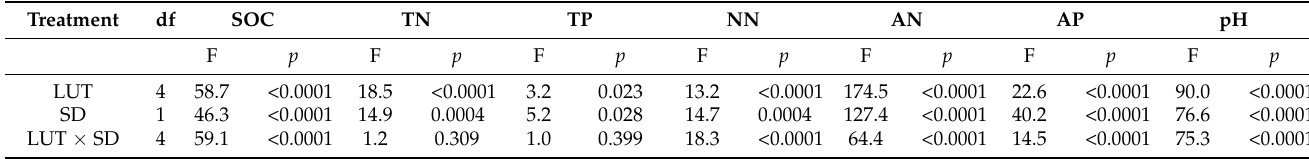
Table 1. Results of two-way ANOVA for the effects of land use type (LUT) and soil depth (SD) on SOC, TN, TP, NN, AN, AP, and pH, F: F-value.